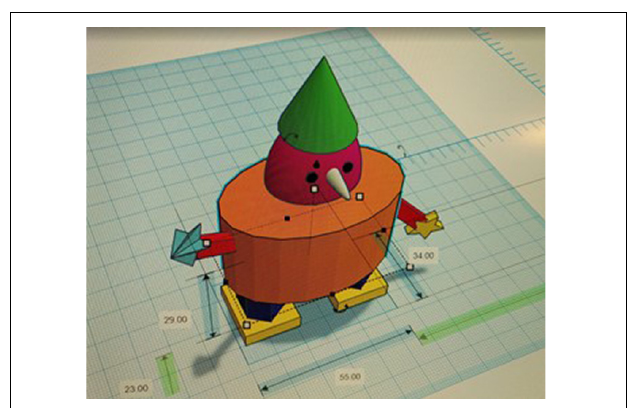
FIGURE 2 | A designed robot with the CAD software.